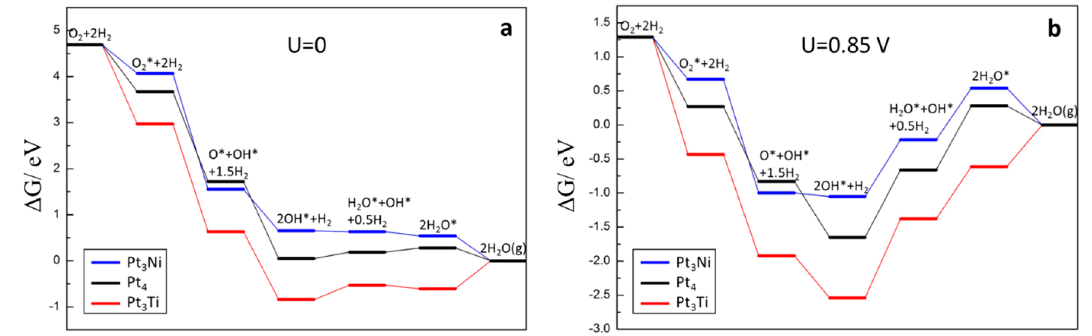
Figure 3. Free energy profiles of ORR on OG-supported Pt 4 (black line), Pt 3 Ti (red line), and Pt 3 Ni (blue line) clusters at 0 V ( a ) and 0.85 V ( b ) with respect to the standard hydrogen electrode (SHE).